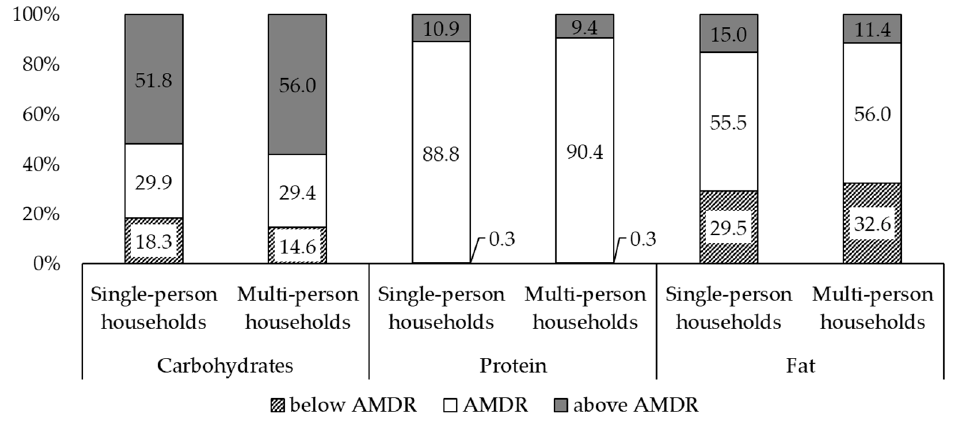
Figure 2. Distribution of Korean adults’ macronutrient intake according to household type,